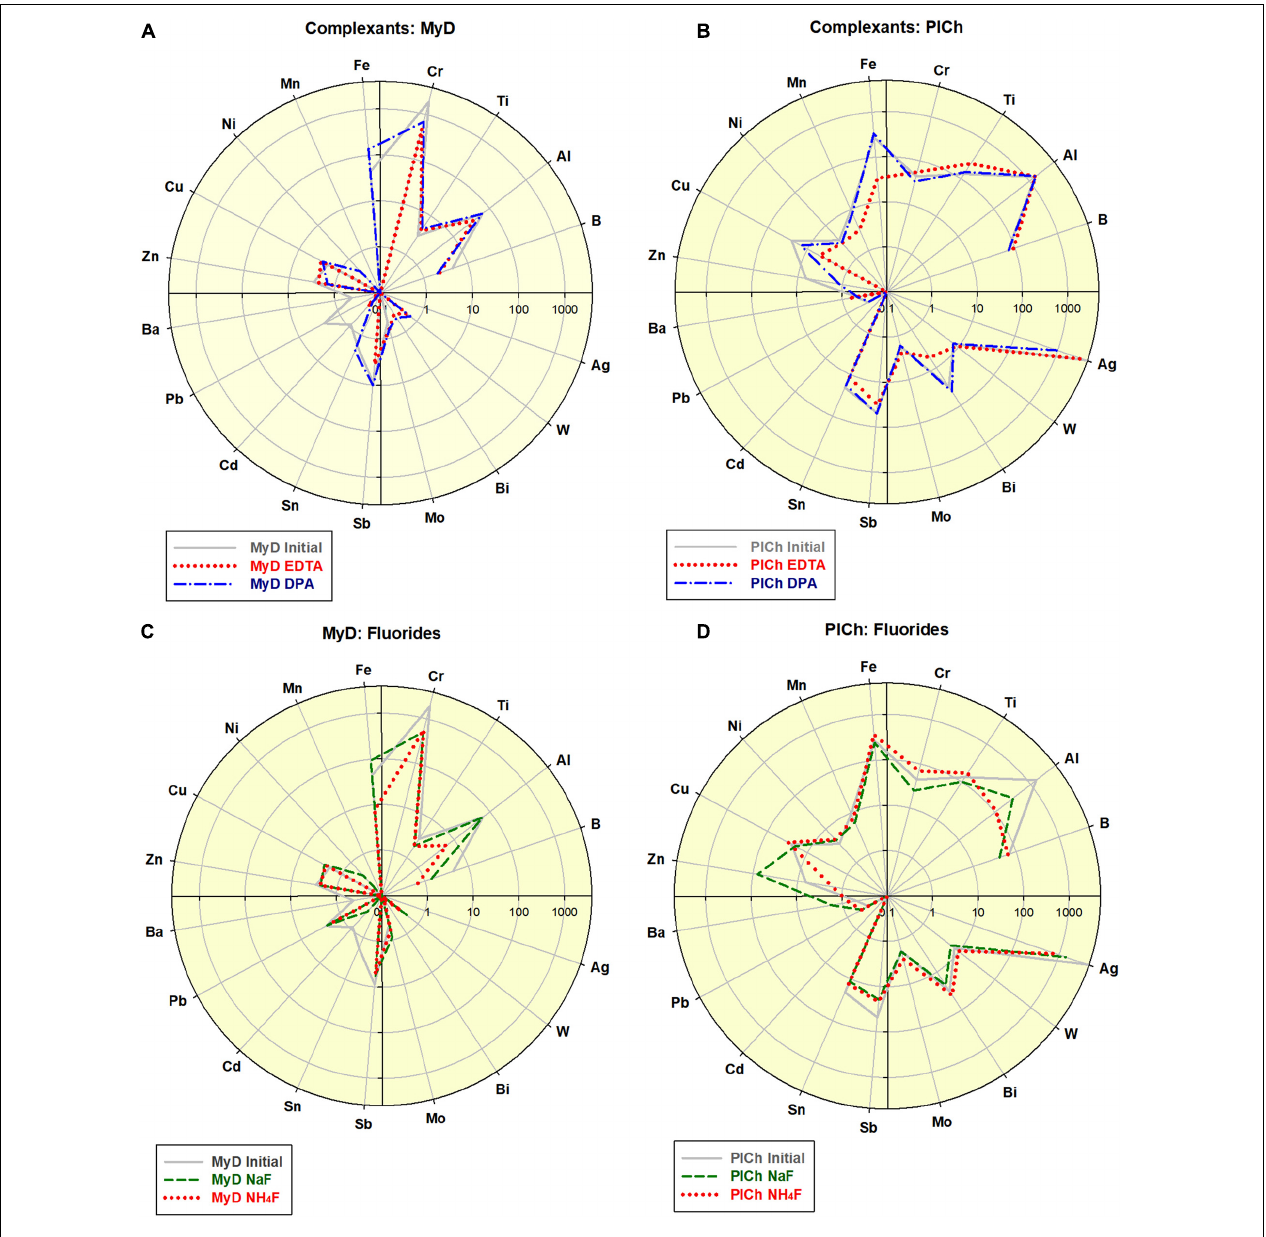
FIGURE 2 | Effects of the complexant-driven refinement (Na 2 EDTA and 2,6-Pyridinedicarboxylic acid (here indexed “EDTA” and “DPA”; see also Supplementary Table B2 ): (A) treatment of MyD; scale 0.1–4,000; (B) treatment of PlCh; scale 0.1–5,000. Effects of the fluorides-driven refinement (NaF and NH 4 F; see also Supplementary Table B2 ): (C) treatment of MyD; scale 0.1–4,000; (D) treatment of PlCh; scale